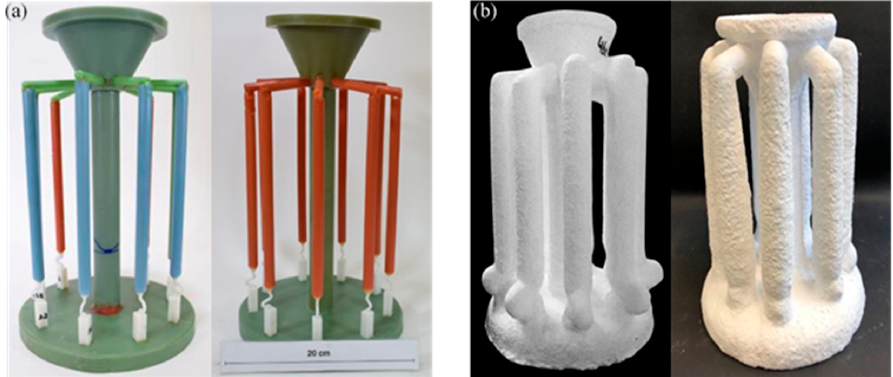
Figure 3. Images of the wax model ( a ) and the shell mold ( b ).